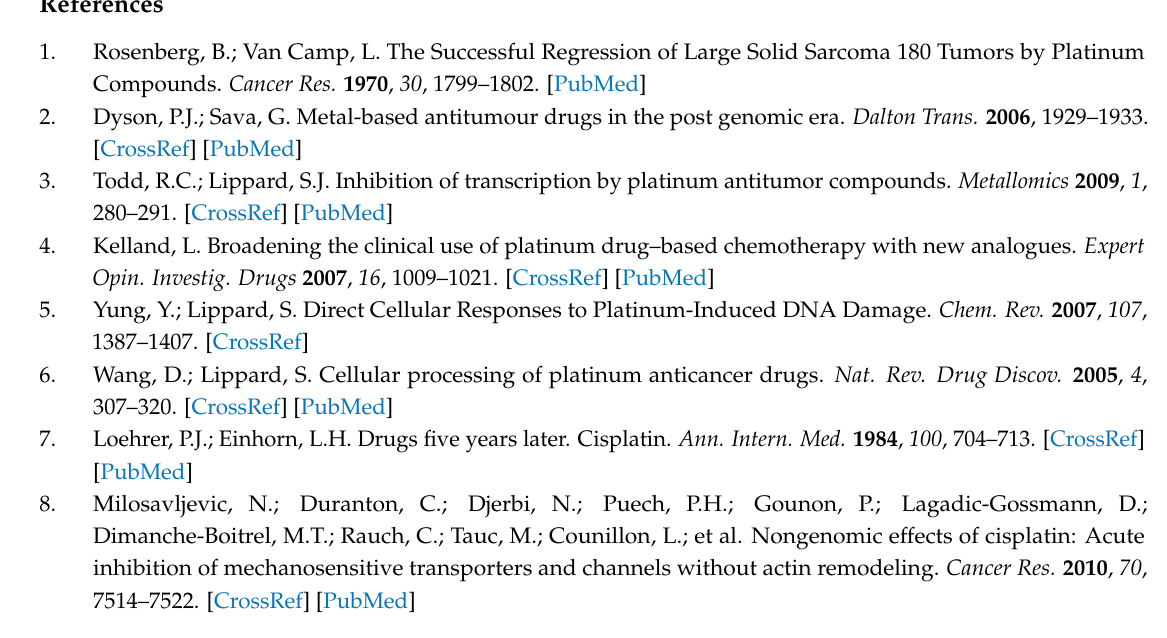
Supplementary Materials: The following are available online. 1 H- and 13 C-NMR data of a tautomeric mixture of 4d and 4d* ; 1 H-and 13 C-NMR data and HRMS of impiridones type 7 ; the experimental details of the cell culturing and the in vitro